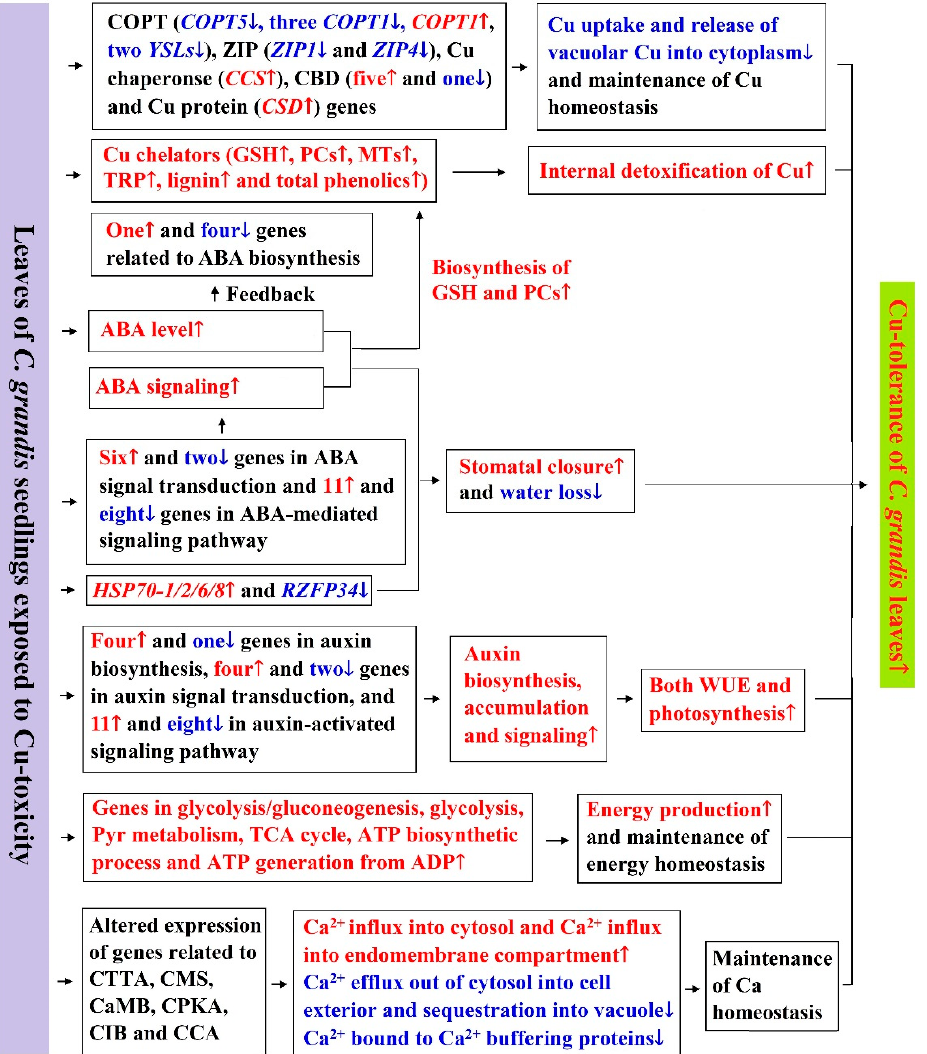
Figure 6. A potential model for the adaptive responses of C. grandis leaves to Cu-toxicity. CaMB, CaM binding; CCA, Ca channel activity; CIB, Ca ion binding; CMS, Ca-mediated signaling; CPKA, CaM-dependent protein kinase activity; CTTA, Ca ion transmembrane transporter activity; HSP70-1/2/6/8, heat shock 70kDa protein 1/2/6/8; Red, upregulation; ↑ ,upregulation; Blue, downregulation; ↓ , downregulation.